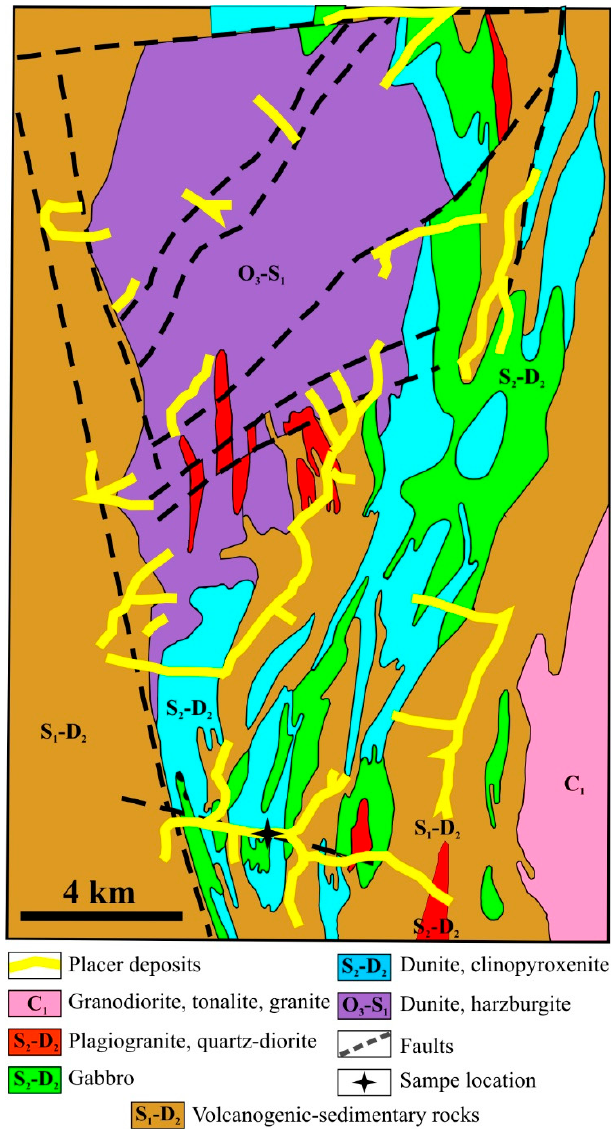
Figure 2. Schematic geological map of the Verkh-Neivinsk massif with locations of Au-PGE placer deposits and studied PGM grains.